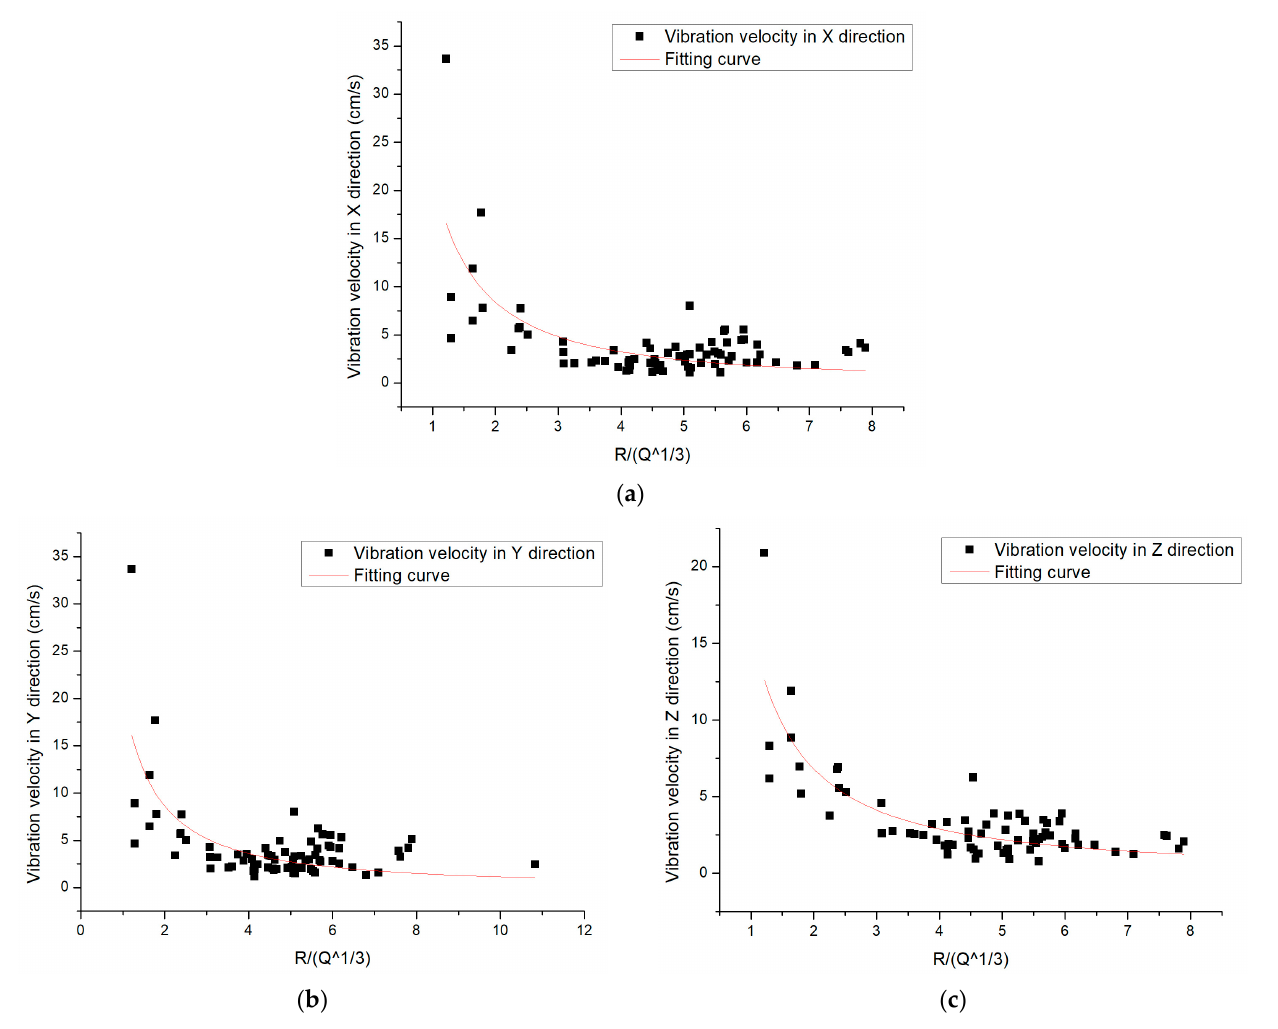
Figure 6. Vibration velocity in three directions of other blast holes behind the working face: ( a ) X direction; ( b ) Y direction; ( c ) Z direction. ( a ) X direction; ( b ) Y direction; ( c ) Z